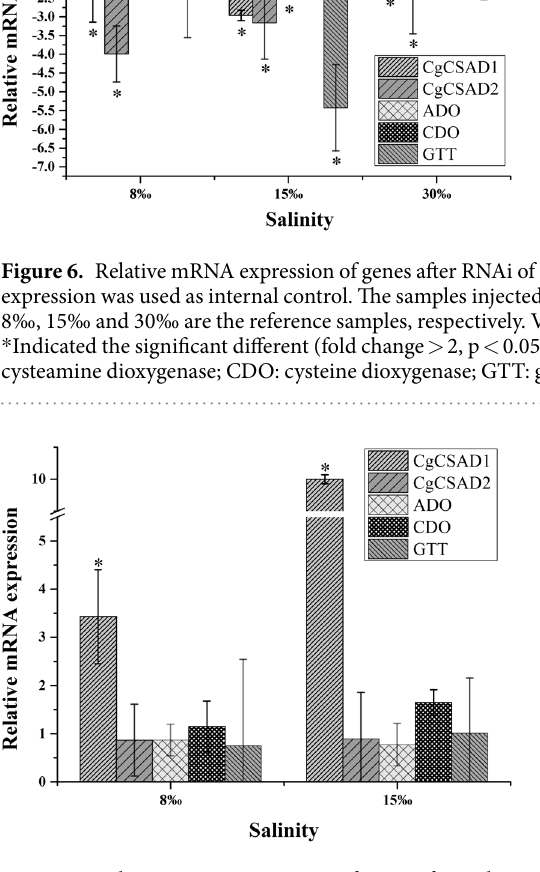
Figure 7. Relative mRNA expression of genes of samples in different salinity after dsRNA injection. Elongation factor 1 α (EF) gene expression was used as internal control. The samples injected with dsRNA of CgCSAD1 and acclimated in 30‰ are the reference samples. The y-axis represent the fold changes between the expressions of treated samples and reference samples. Vertical bars represent the mean ± SD (N = 6). * Indicated the significant different (fold change > 2, p < 0.05). CSAD: Cysteine sulfinate decarboxylase, ADO: cysteamine